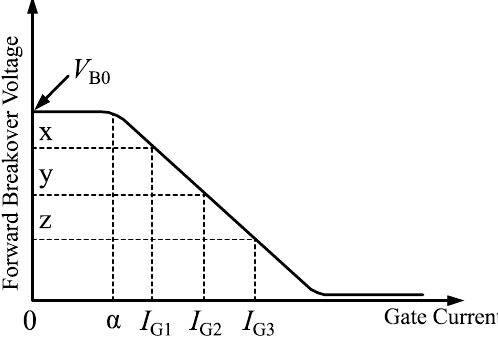
Figure 3. Qualitative variation of Breakdown Voltage ( V B 0 ) vs. Gate Current ( I G ): the correct way to turn on a SCR device is to apply a fast current pulse with suitable amplitude on the gate terminal when a positive voltage is applied between anode and cathode to reduce the Breakover Voltage of the device.